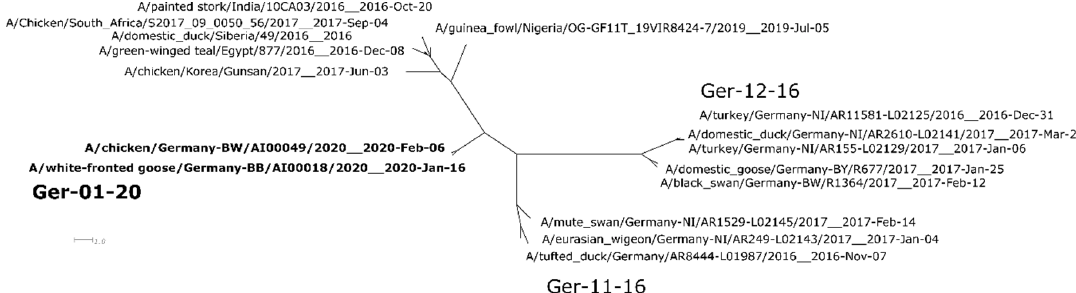
Figure 2. Supernetwork of full genomes of selected worldwide clade 2.3.4.4b H5N8 subgroups from maximum likelihood (ML) trees of PB2, PB1, PA, HA, NP, NA, MP, and NS segments. ML analyses were done using RAxML, including bootstrapping for 1000 iterations and network analyses conducted with SplitsTree4.